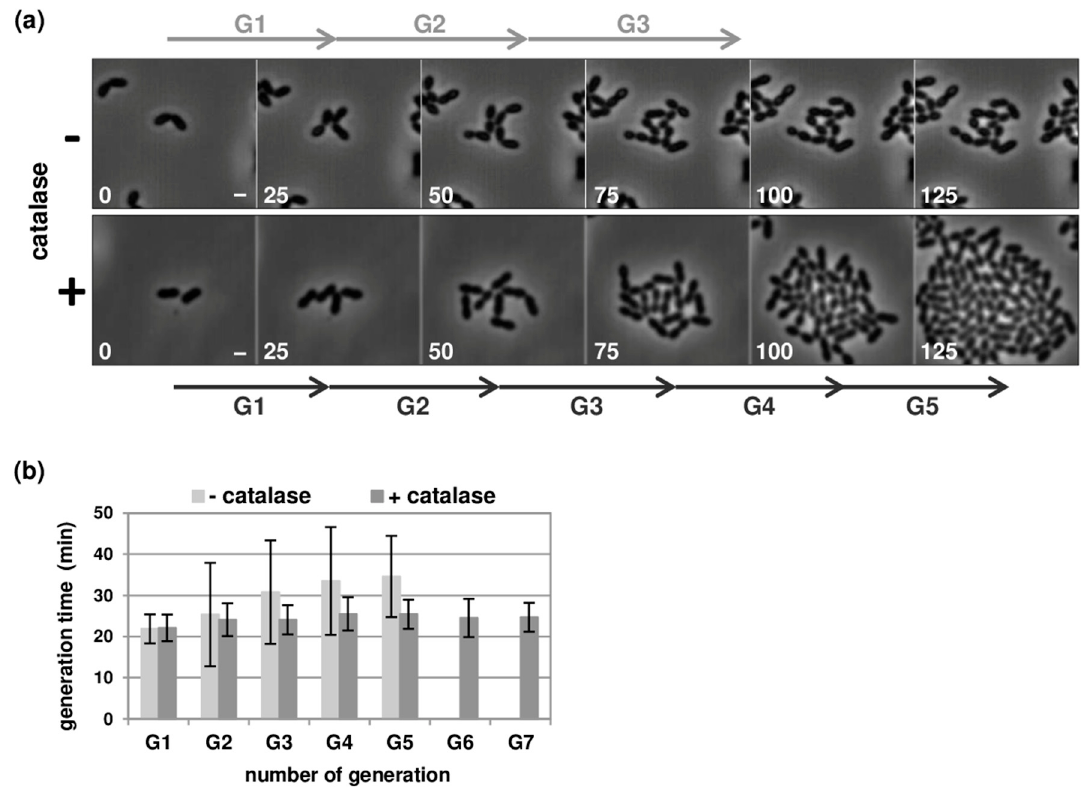
Figure 1. Growth of Streptococcus pneumoniae in the CellASIC ® ONIX microfluidic device. ( a ) Still images from time-lapse microscopy of R1501 ( ∆ comC ) cells grown at 37 ◦ C under a flow rates of 0.3 µ L / h in C + Y medium supplemented (bottom panel) or not (top panel) with catalase (300 U / mL). Images were captured at 5-min intervals during 5 h. Representative phase contrast images captured during the two first hours are shown. Time is indicated in minutes. G1 to G5 and arrows indicate successive cell division events. Scale bar, 1 µ m; ( b ) Histograms indicating the variation of the generation time over successive cell division events. Generation times were calculated by manually monitoring individual cells lineages over 7 rounds of division (G1 to G7). Note that cell growth stops after 5 cell division events without catalase. A minimum of 50 cell lineages were analyzed in each condition for each experiment. Values and standard deviations are based on data from three independent experiments.